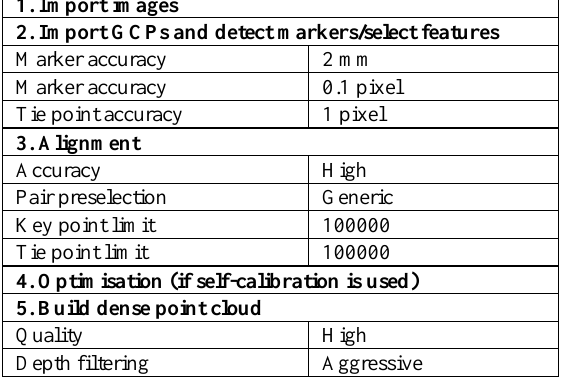
Table 3. General workflow and main parameters used with PS.